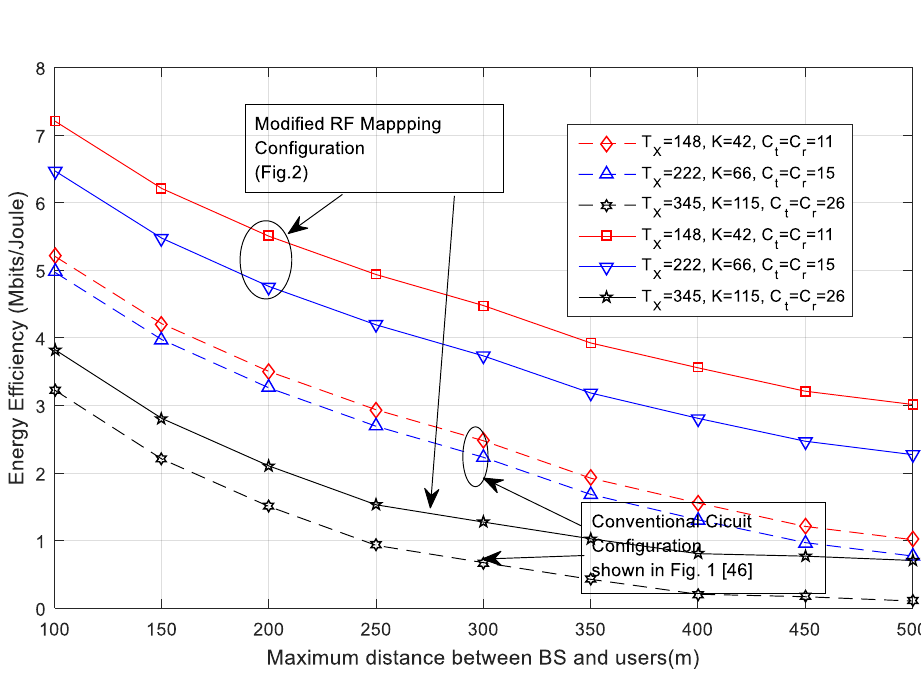
Figure 6. Energy E ffi Figure 6. Energy Efficiency.